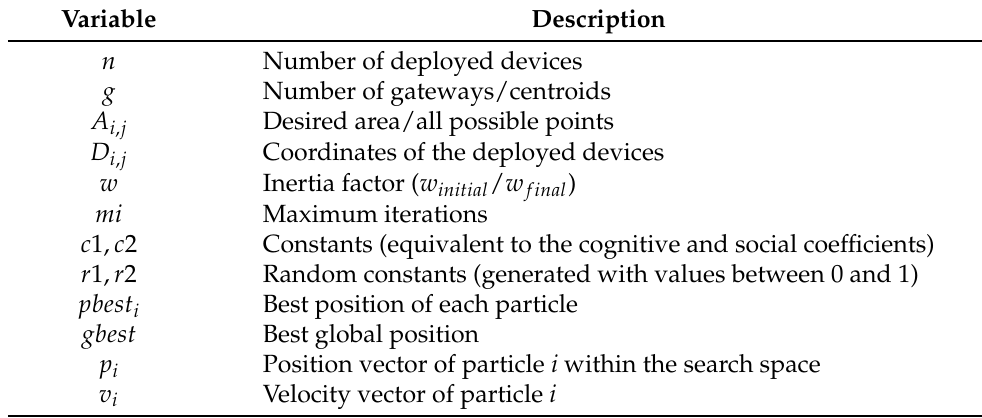
Table 5. The variables that were used for the PSO